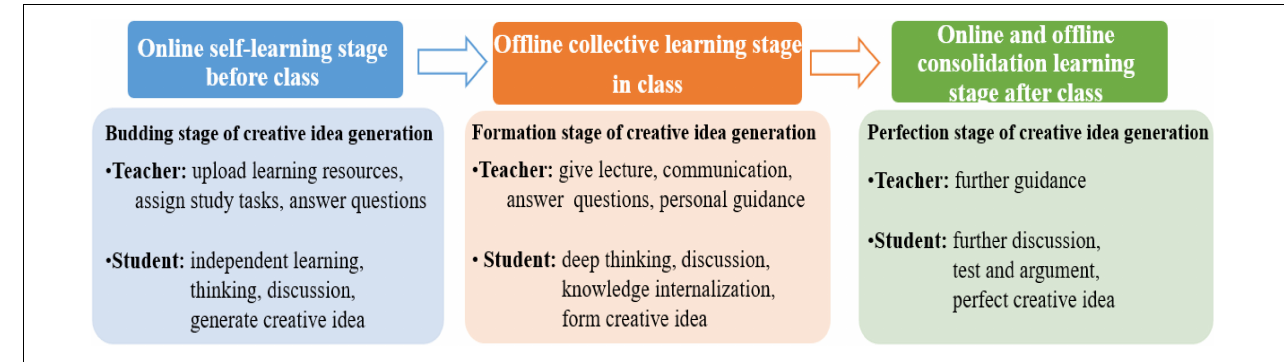
FIGURE 1 | Creative idea generation diagram of blended